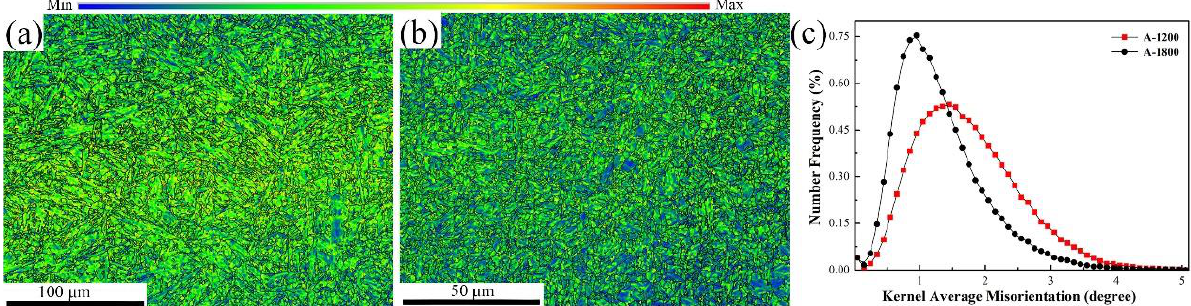
Figure 9. KAM maps of ( a ) A-1200 steel and ( b ) A-1800 steel, as well as ( c ) their KAM fractions.